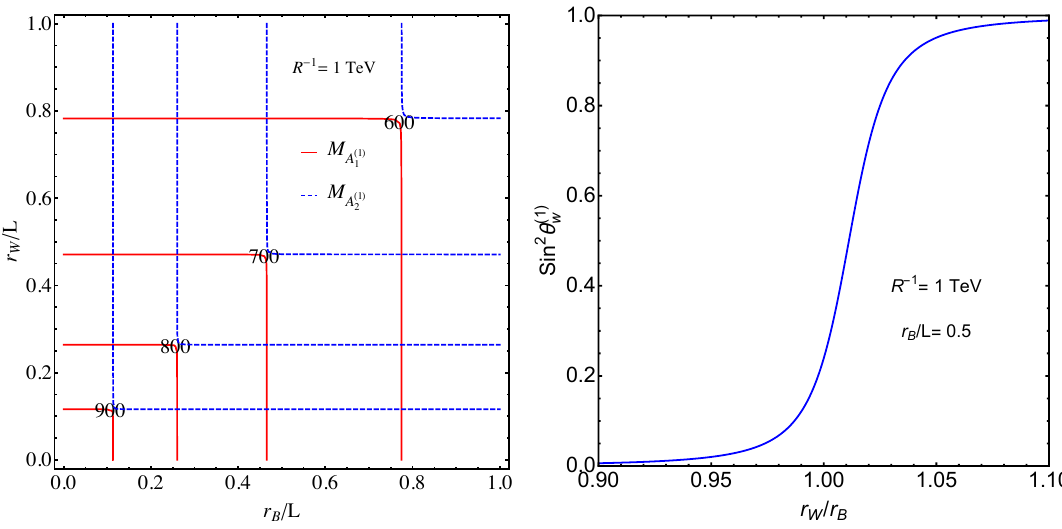
Figure 1 . Left: contours of constant mass for the level 1 electroweak KK bosons A (1) contours were made assuming R (cid:0) 1 = 1 TeV, and they show the mass dependence on the boundary terms r B and r W . Right: the level 1 KK Weinberg angle sin 2 (cid:18) (1)